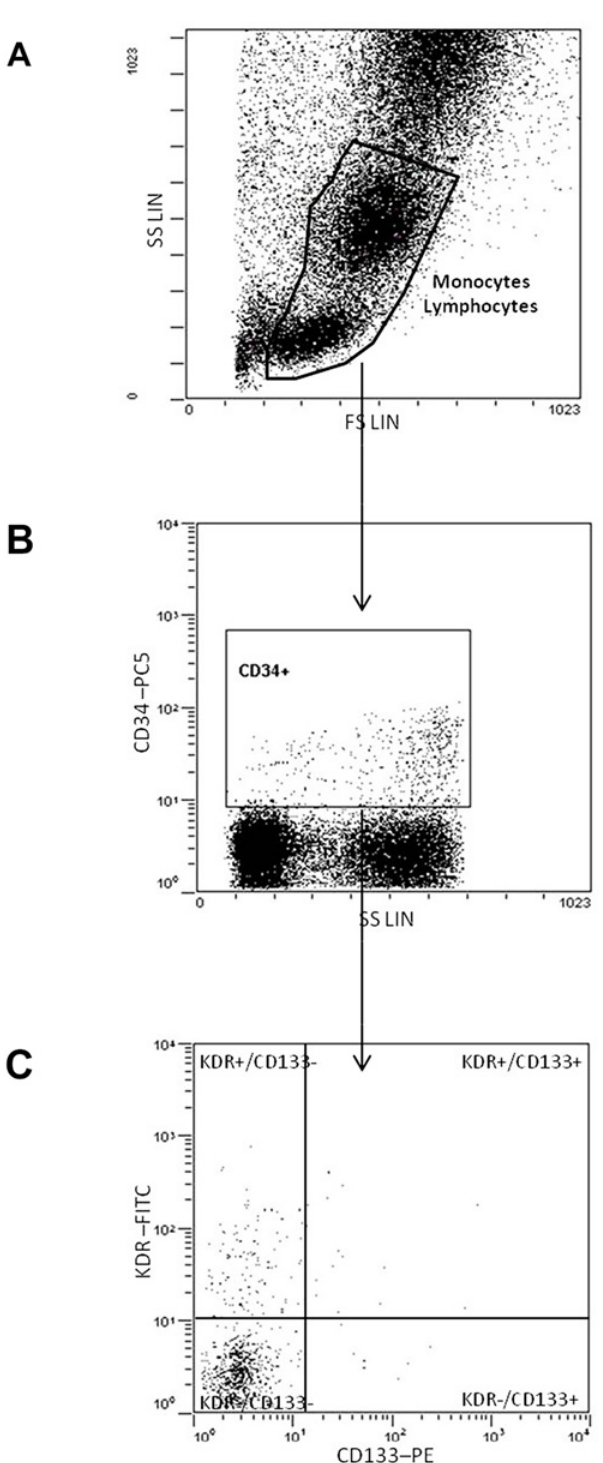
Fig 1. Example of gating strategy of EPCs by FACS. (A) Lymphocytes and monocytes were gated in lineal FSC/SSC plot. (B) CD34+ positive events were gated in a lineal SSC/log CD34-PC5 plot as a subpopulation of lymphocytes and monocytes gate. (C) CD34+/KDR+/CD133+ events within CD34+ gate were detected in a log AC133-PE/log KDR-FITC plot.